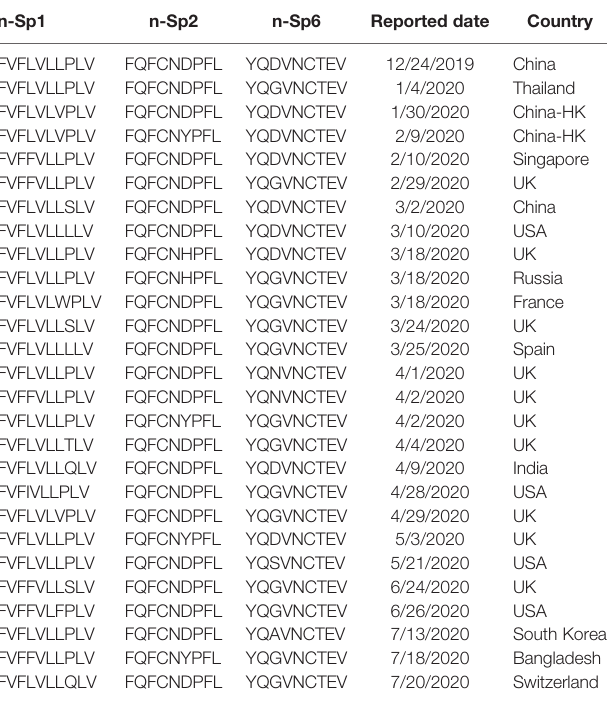
TABLE 4 | The fi rst reported mutation of SARS-CoV-2 main